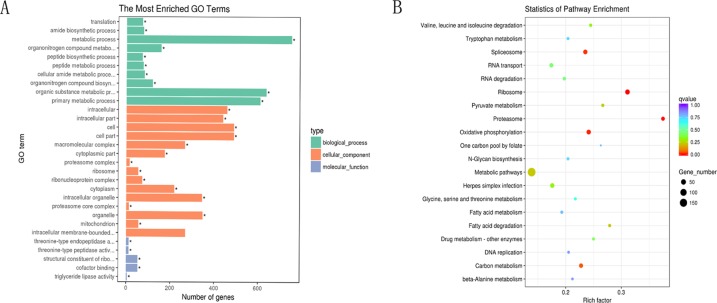
GO and KEGG analyses of the DEGs in the circRNA–miRNA–mRNA network. (A) GO analysis for DEGs in the circRNA–miRNA–mRNA network. X-axis represents the number of genes. The Y-axis on the left represents the GO term, and the Y-axis on the right represents GO type. The green column means the biological process, the red column means the cellular component, and the gray column means the molecular function. (B) Statistics of pathways enrichment of DEGs in the circRNA–miRNA–mRNA network. Color of the points refer to the q-value of the respective signaling pathway. Size of the point refers to the number of genes within each pathway.